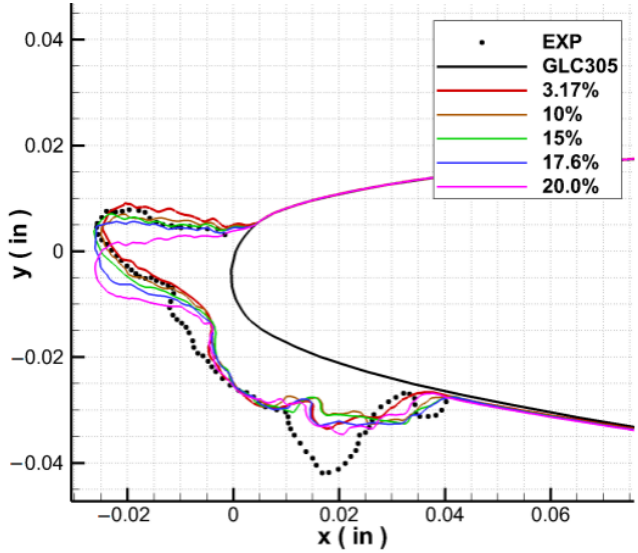
Figure 8. Ice shape of GLC305 airfoil at different blockages.